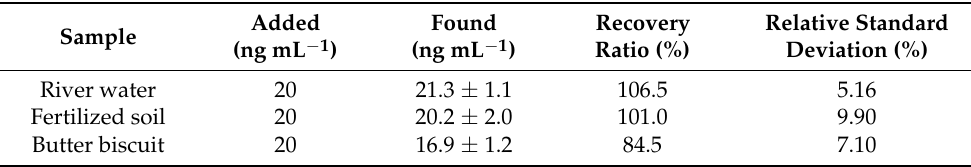
Table 2. Determination of the simulated abrin specimens (n = 3).